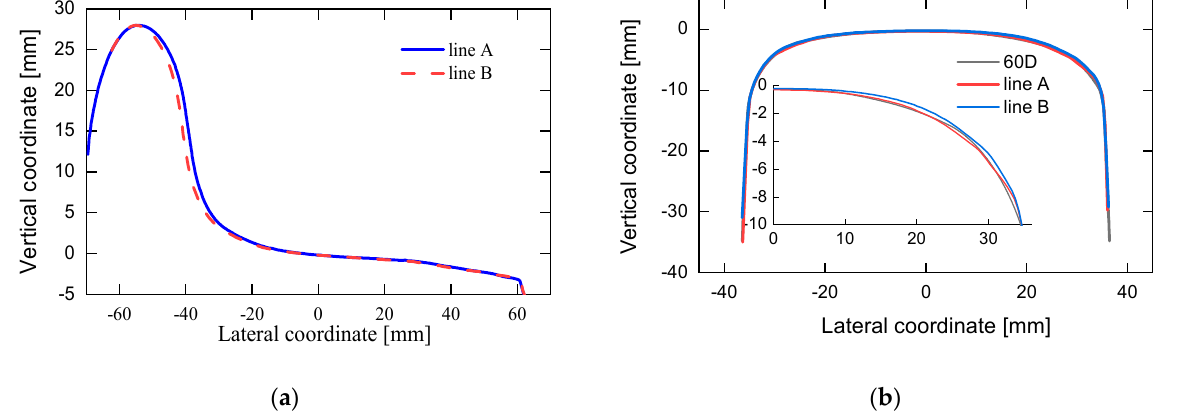
Figure 4. Profiles of two railway lines’ wheels and rails: ( a ) re ‐ profiling shapes and ( b ) rail profile. The measured rail profiles of the two lines are identical to the 60D profile, as shown in Figure 4b. The rail profile of the Line B with a certain positive deviation slightly bugles at the working side gauge. The rail grinding profile by the grindstone, so the